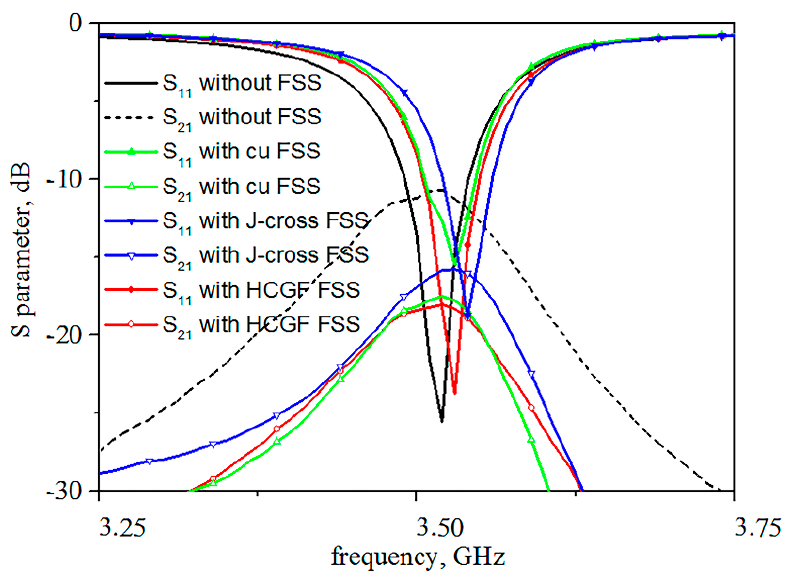
Figure 10. S-parameters measurement results of 1 × 2 DRA MIMO antennas with different FSSs. In addition, normalized radiation patterns of the antenna at 3.5 GHz are measured in the microwave anechoic chamber. We observed from Figure 11 that the radiation properties of the antenna are hardly influenced by the proposed FSS.